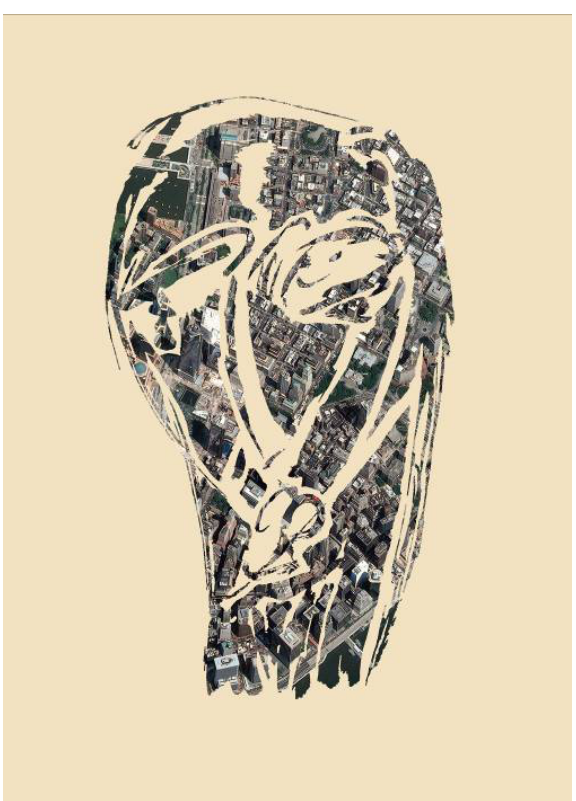
Figure 4 Tamer Assem – Cairo Man – Digital Print – 70x50cm –